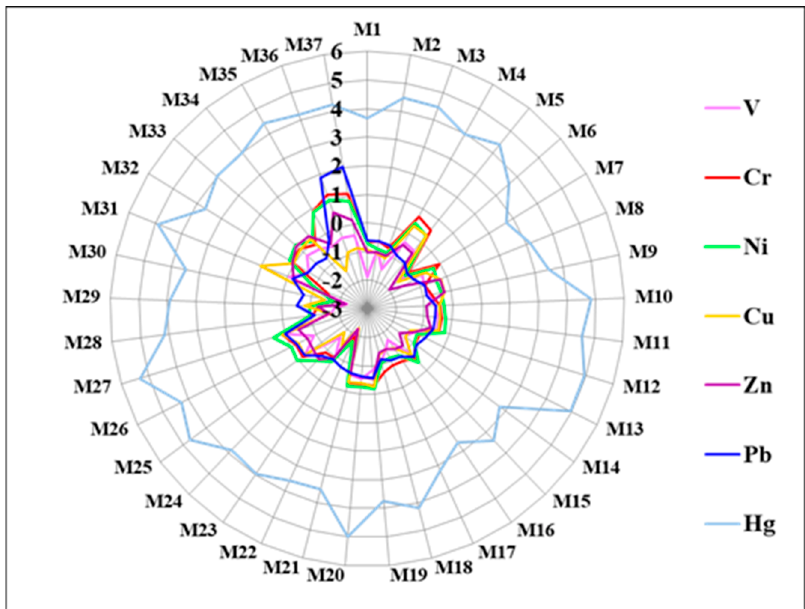
Figure 2. Geo ‐ accumulation index (I geo ) of selected metals in the soil. Figure 2. Geo-accumulation index (I